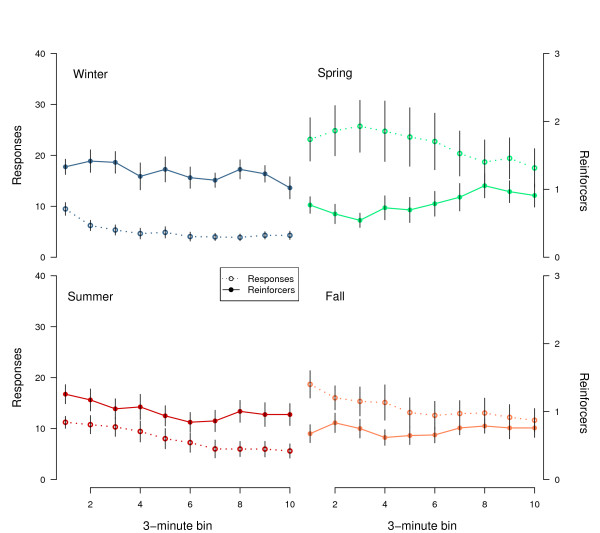
Performance within sessions on the Differential Reinforcement of Low Rate (DRL) task. Mean ± SEM (n = 15) of number of responses (left axis, dotted lines) and number of reinforcers (right axis, solid line) are plotted for each 3 minute period in the 30 m session.